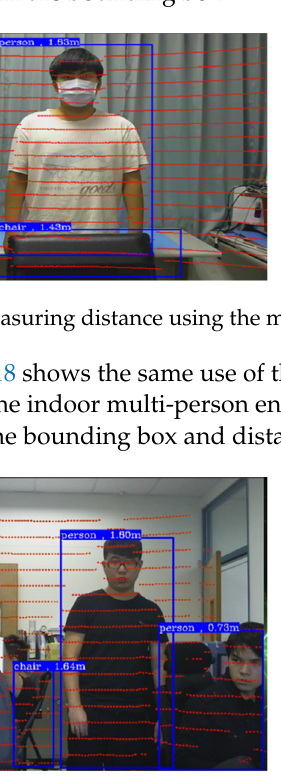
Figure 18. Distance measurement for multi-person environments.